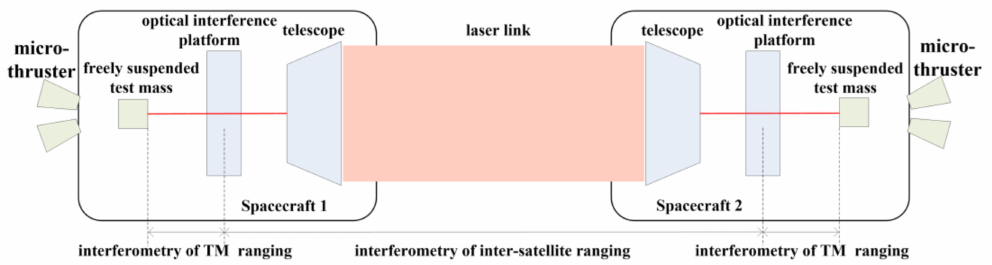
Figure 7. Interferometry of ranging between two test masses (side